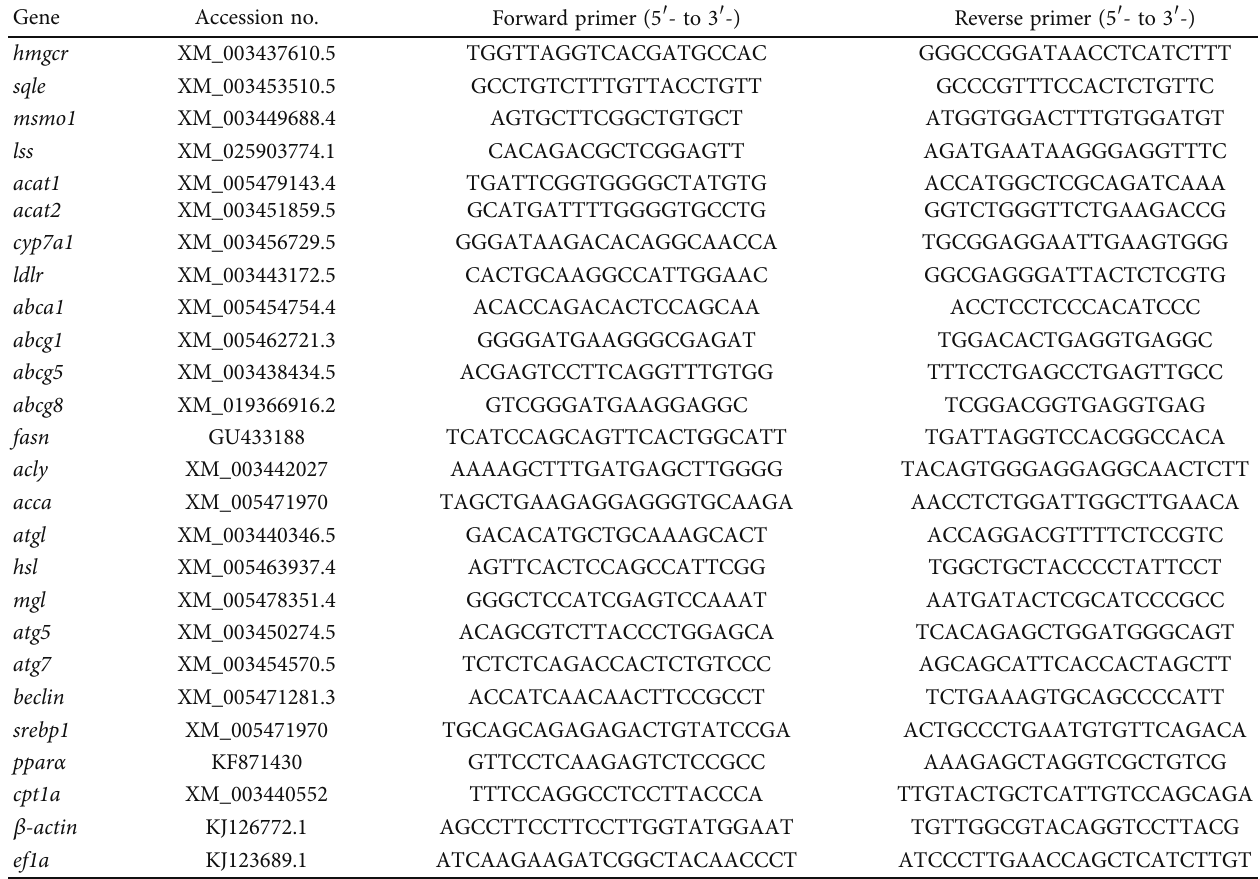
Table 2: The primer sequences used in the